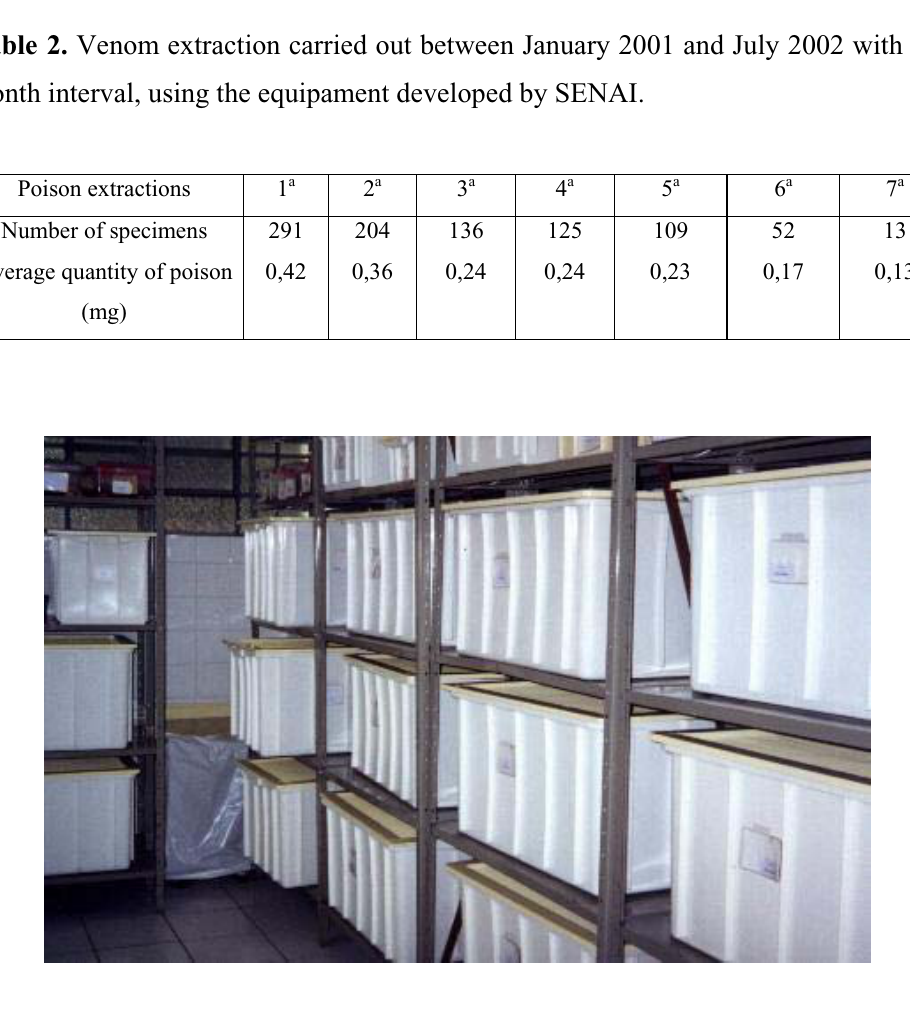
Figure 1. The bioterium of scorpions of the Laboratory of Arthropods at Instituto Butantan. D. M.